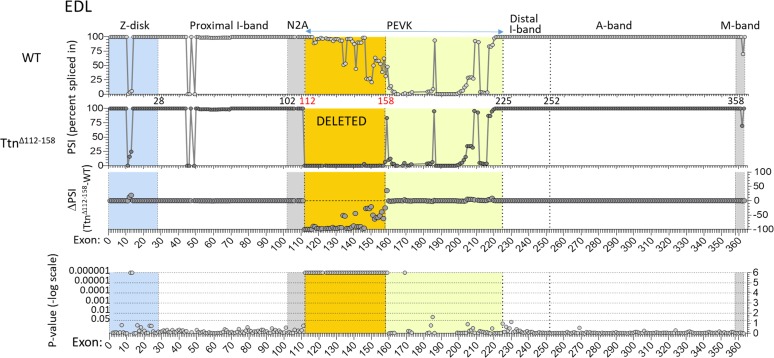
Titin expression analysis in EDL muscle.RNAseq-based titin exon expression of EDL muscle, expressed as percent spliced-in (PSI) in WT and Ttn∆112-158 mice (top and below), and the PSI difference between the two genotypes and the p-value of the PSI difference (bottom and above). The targeted exons are absent in the Ttn∆112-158 mouse with minimal changes elsewhere. p-value scale is –log(p-value) with values > 6 shown as 6.